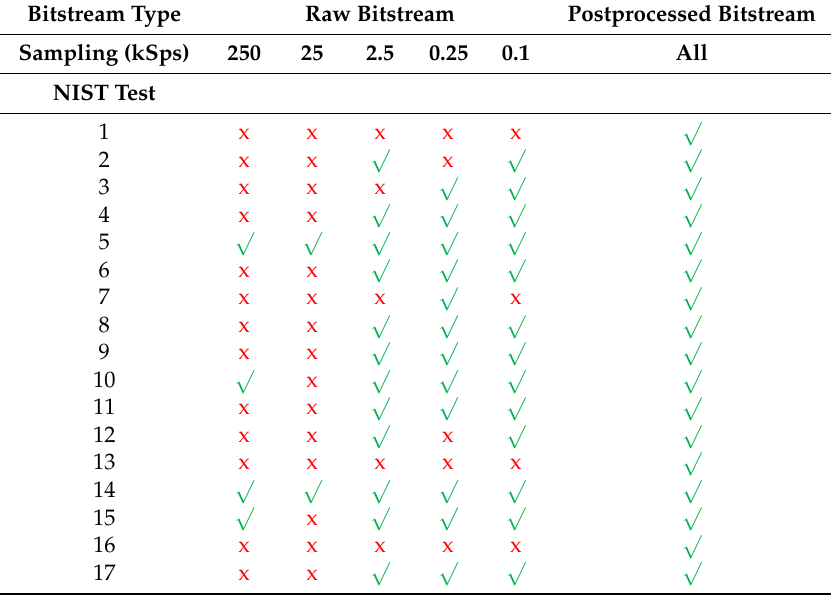
Table 1. NIST test results for bitstreams obtained at different sample